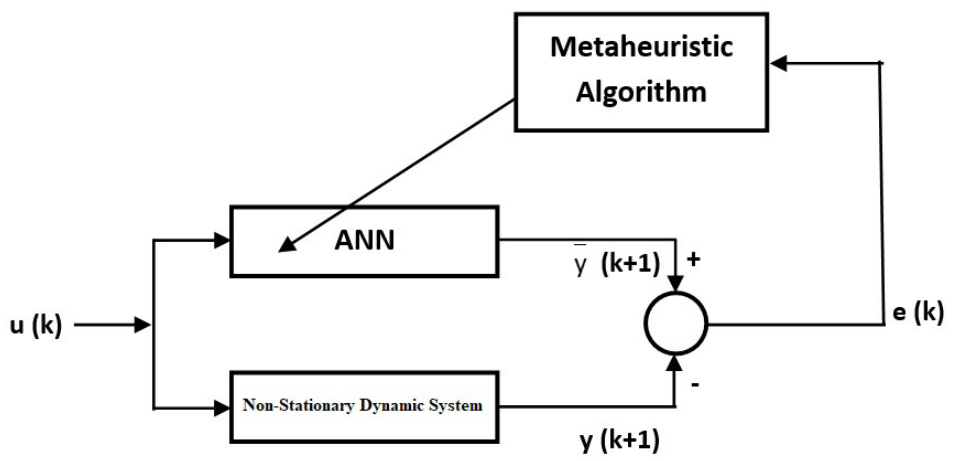
Figure 3. A block diagram of the identification of non-stationary dynamic systems with the proposed